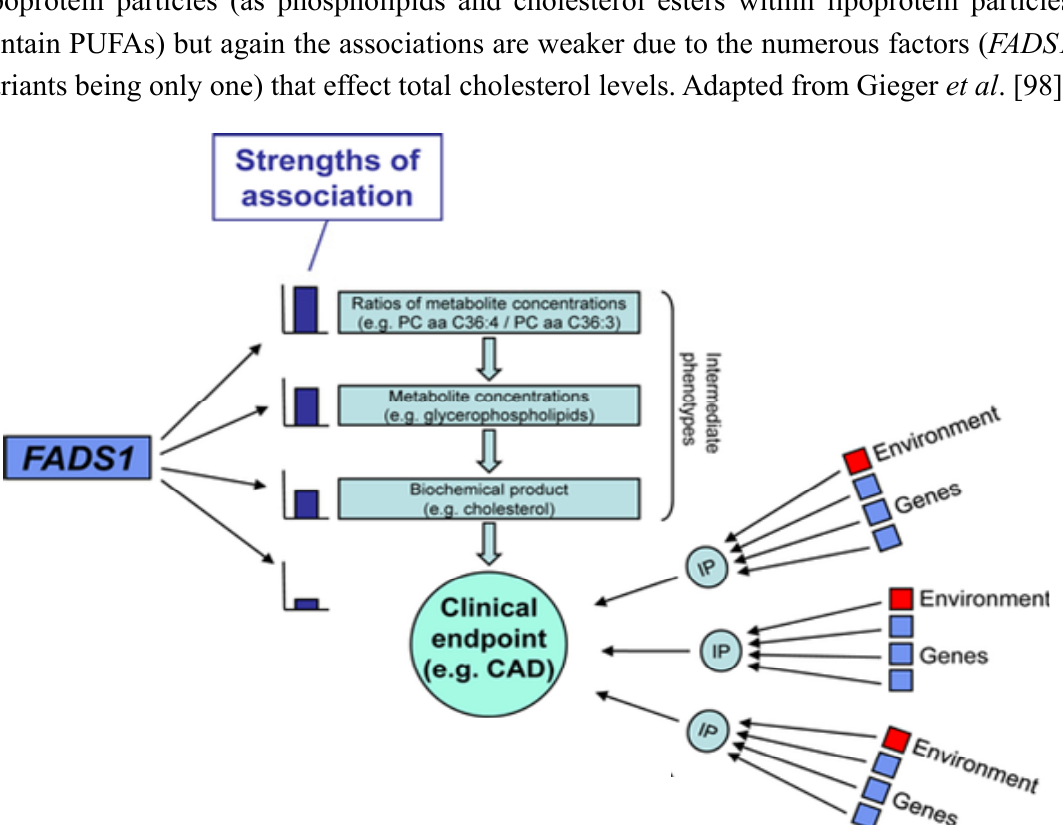
Figure 3. Associations between FADS1 variants and intermediate, molecular phenotypes (IPs), such as metabolic traits. This figure illustrates that the strength of an association is related to the molecular step(s) and metabolite(s) most impacted by genetic variants. In this case, FADS1 variants are most strongly associated with the conversion DGLA to ARA, and thus there are strong associations between the ratio of ARA-containing phospholipids to DGLA-containing phospholipids. This in turn impacts levels of circulating and cellular phospholipid, but the association with FADS1 variants is not as strong because more molecular steps are involved. Levels of phospholipids in turn affects cholesterol levels in lipoprotein particles (as phospholipids and cholesterol esters within lipoprotein particles contain PUFAs) but again the associations are weaker due to the numerous factors (